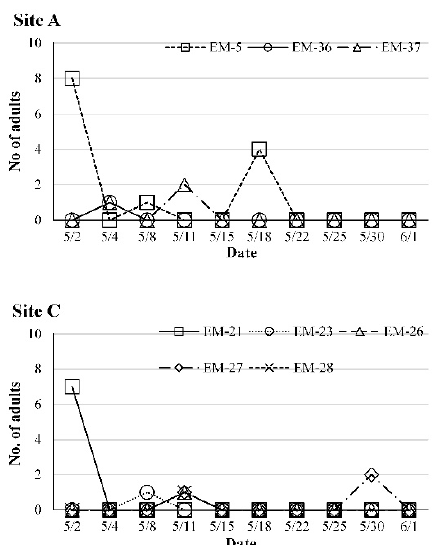
Figure 2. Seasonal abundance of O. kuvanae by egg mass on different oviposition sites based on laboratory incubation of L. delicatula eggs in 2016.